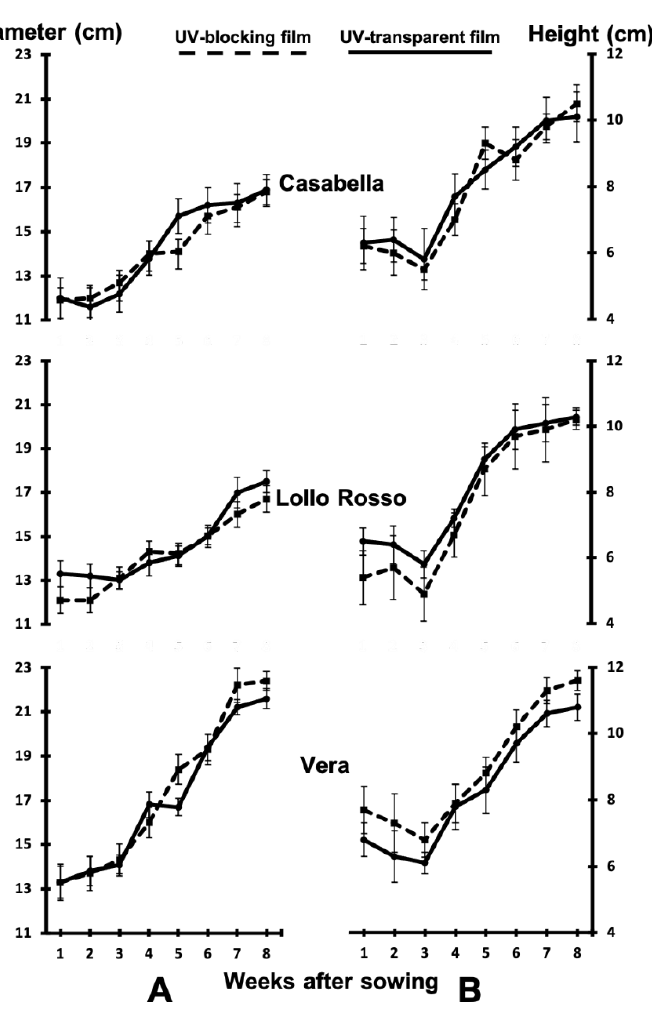
Figure 3. Effects of plastic sheeting on diameter ( A ) and plant height ( B ) in three cultivars of lettuce. Vertical bars show standard error (SE) ( n = 18). * indicates significant differences within each cultivar between UV-transparent and UV-blocking films according to LSD test at p < 0.05. No symbol indicates no differences.